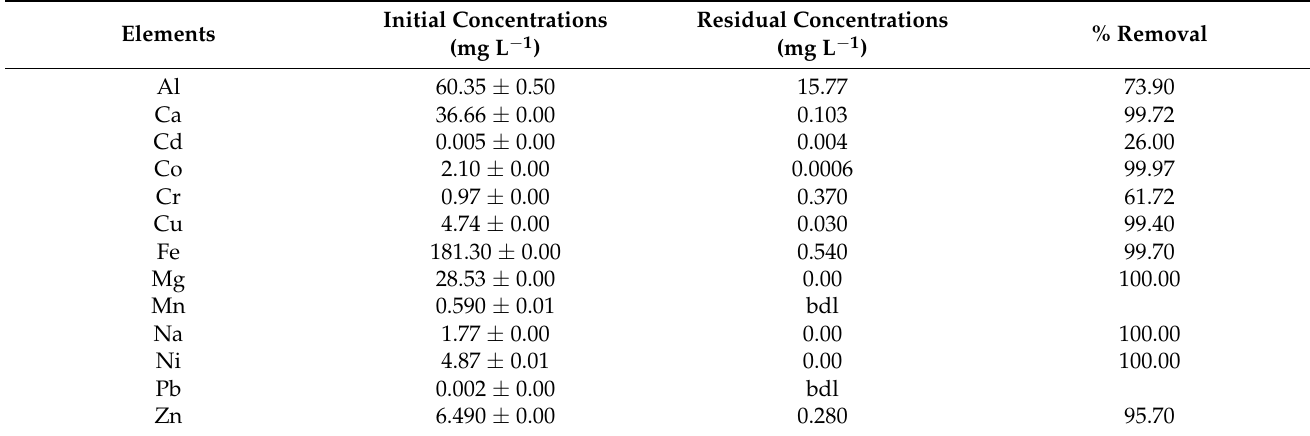
Table 4. Sampling site RTW1.